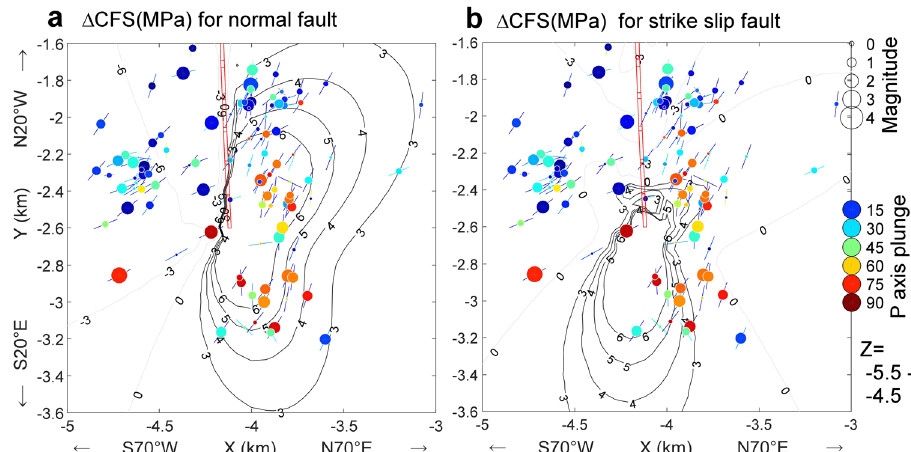
Fig. 4 Distributions of P axis plunges, T axes, and Δ CFS around the southern edge. a Filled circles indicate the P axis plunges of aftershocks occurring within a 2 × 2 × 1 km 3 volume centred at the estimated fault edge at the depth of 5 km. Normal faulting aftershocks are characterised by P axis plunges greater than 60°. T axes are also projected onto the horizontal plane. Δ CFS are denoted for normal faulting aftershocks with a fault strike of N110°E, a plunge of 45°, and a slip direction of − 90° with black contours of 3, 4, 5, and 6 MPa and grey contours of 0, − 3, and − 6 MPa. b Δ CFS for the same strike- slip fault as the mainshock. The other items in the fi gure are the same as for ( a ). The red line indicates the estimated fault plane at the depth of 5